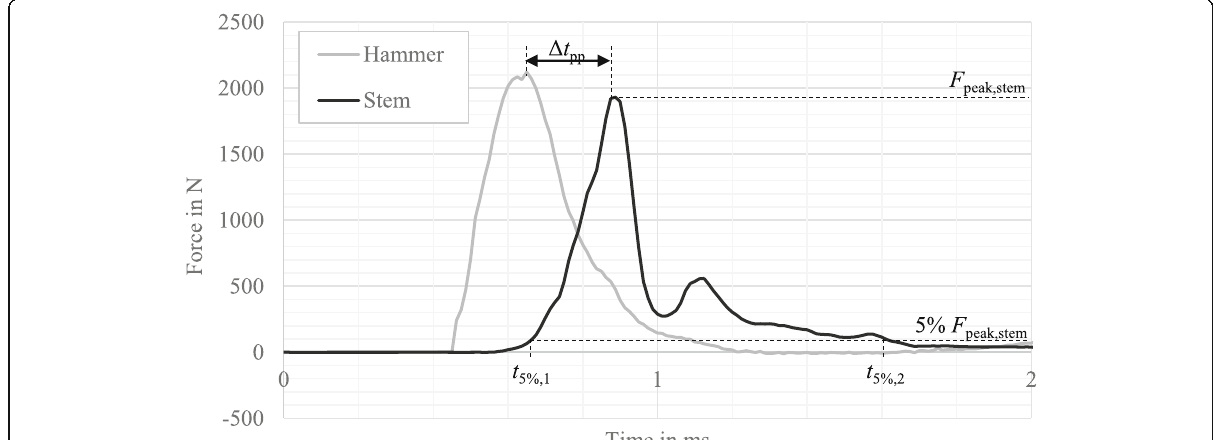
Fig. 5 Force curves measured by sensors in hammer and neck of the stem while